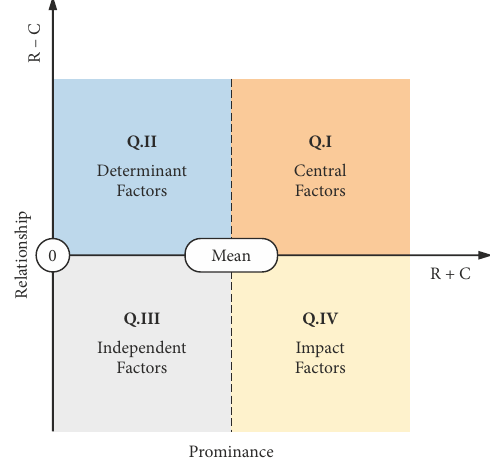
Figure 1. DEMATEL cause-effect relationships map (Yazdi et al., 2020, p.